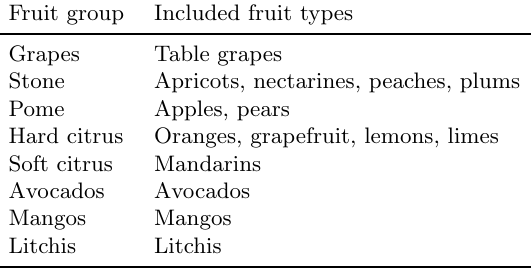
The different fruit groups determined during the data gathering process by studying the cold chain protocols set by the PPECB. Note that fruits belonging to the soft citrus group are often called